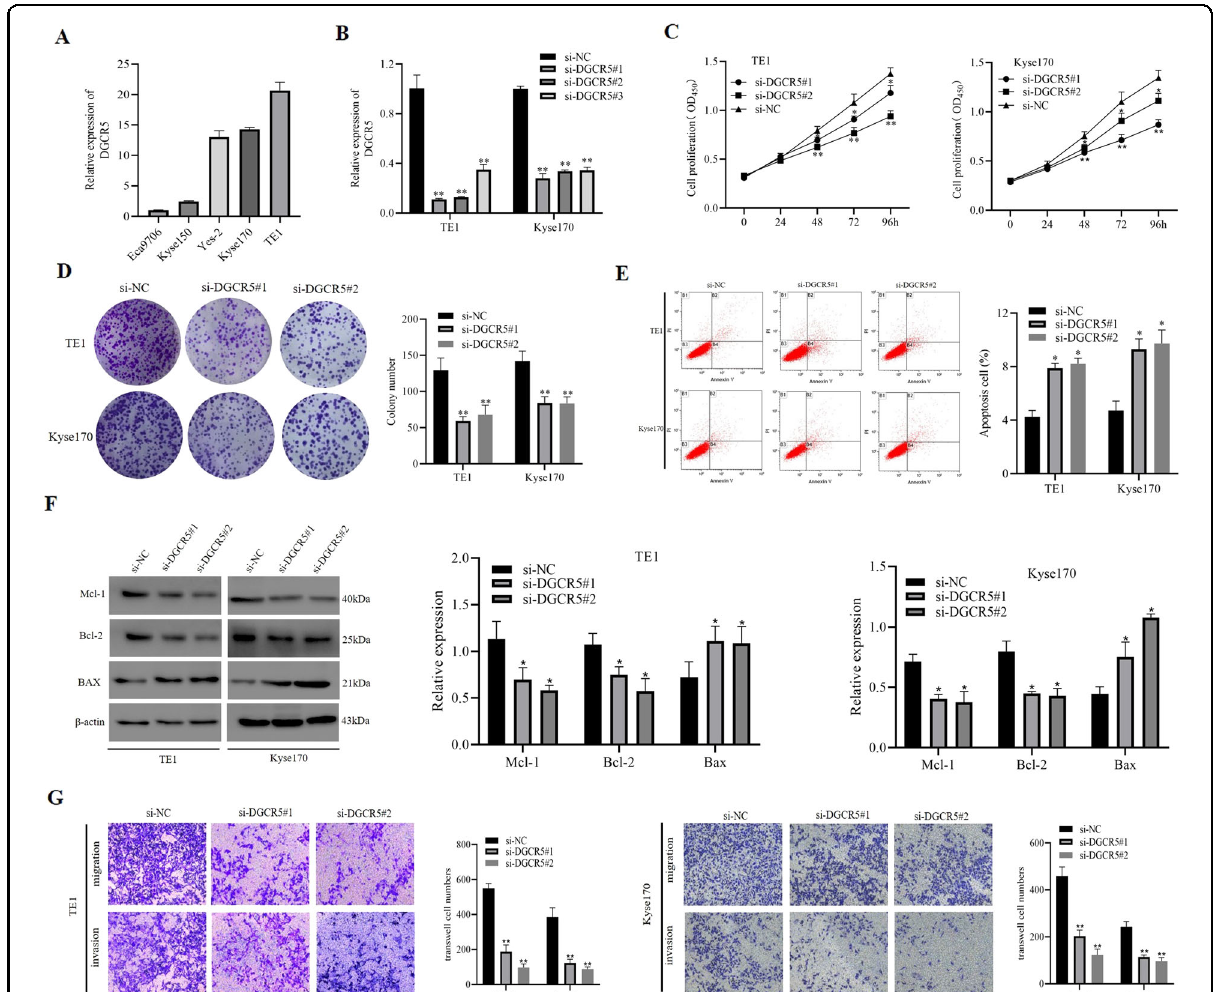
Fig. 2 The expression and functions of DGCR5 in TE1 and Kyse170 cells. A DGCR5 expression on ESCC cells (Eca9706, TE1, Yes-2, Kyse150, and Kyse170) was examined by qRT-PCR. B qRT-PCR analysis for expression levels of DGCR5 on TE1 and Kyse170 cells after transduction with siRNA- DGCR5. C Cell proliferation analysis was performed with CCK-8 assays. Cell viabilities were measured at fi ve different time points. D DGCR5 knockdown remarkably inhibited cell proliferation by colony formation. E , F Veri fi cation of DGCR5 knockout affects the apoptosis on ESCC cells by FACS and western blot. G DGCR5 knockdown inhibited cell migration and invasion by transwell migration and invasion assays. * P < 0.05 and ** P <